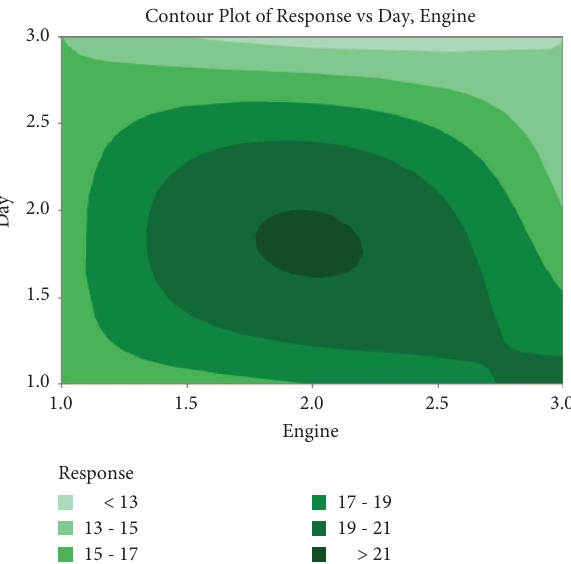
Figure 18: Contour plot of response vs. day vs. engine. Surface Plot of Day vs Engine, Burner